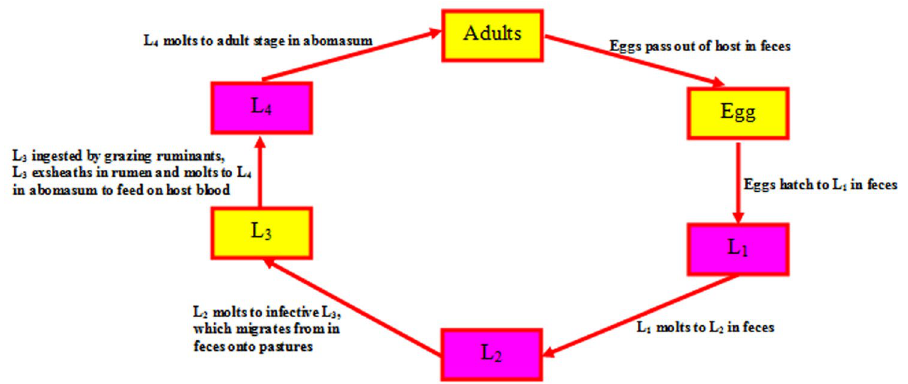
Figure 3. The basic life-cycle pattern of H. contortus .